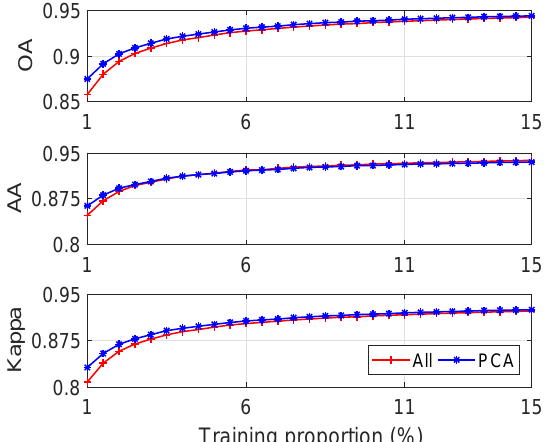
Figure 18. Comparative resultsbetween SVM with PCA (blue* line) and SVM with all bands (red+ line). x-axis denotes different proportions of training